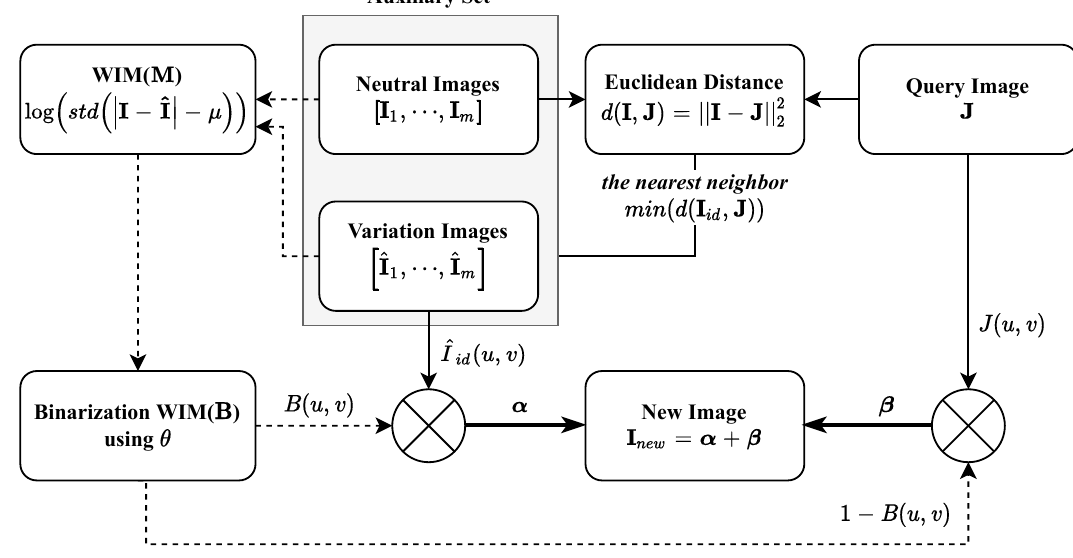
Figure 1. Overall procedure of the proposed